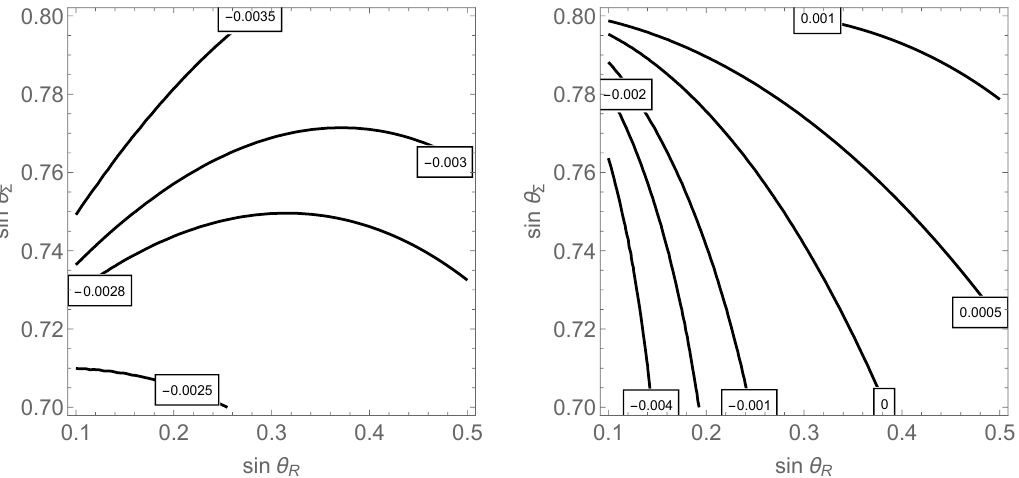
Figure 4 . Contour lines of S (left panel) and U (right panel) for the case m 1 = 3 TeV and tan (cid:12) =